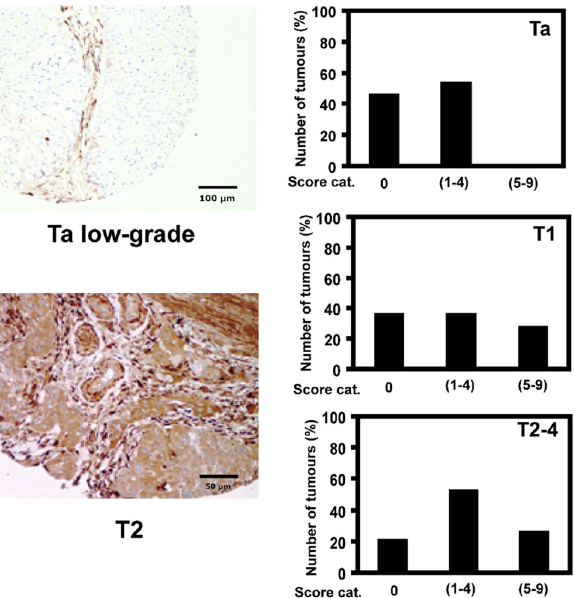
Figure 4. Expression of GAL1 in bladder cancer: Left, IHC images. Scale is specified in the panels. Right, score distribution between stages (Ta, T1 and T2–4). This analysis showed that the cytoplasmic GAL1 expression in the tumor cells was significantly higher (P < 0.05) in T1 tumors and in poorly differentiated stages (T2–4) than in Ta tumors. Stroma and blood vessels also stained positively in all tumors. Only the tumor cell ‐ staining was scored. Reproduced with modifications from 11 , with permission from BJU International, John Wiley &